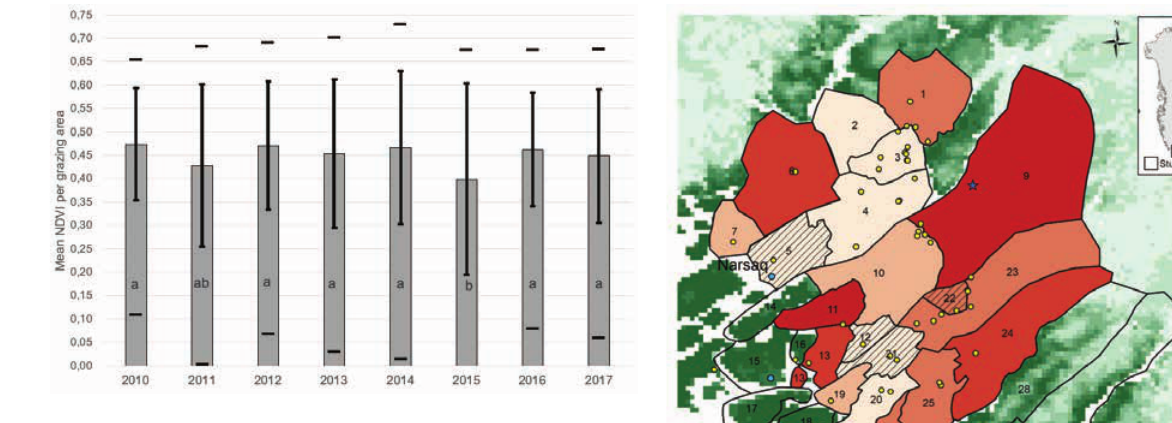
Figure 2: Mean and SD of NDVI per grazing area for years 2010-2017. Top and bottom horizontal bars represent maximum and minimum, respectively. Different letters denote significant differences with P < 0.05